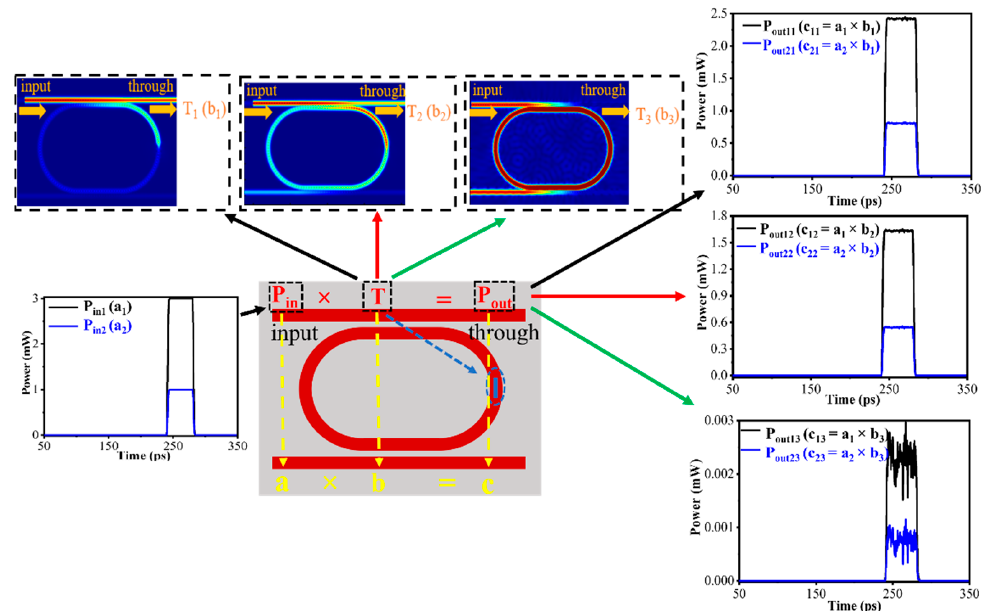
Figure 6. Schematic diagram of the scalar multiplication P in × T = P out. Two read pulses P in1 (black curve) and P in2 (blue curve) with different amplitudes are input into the devices with different GSST states representing different T. The corresponding outputs (P out ) can be obtained by measuring the device transmission.